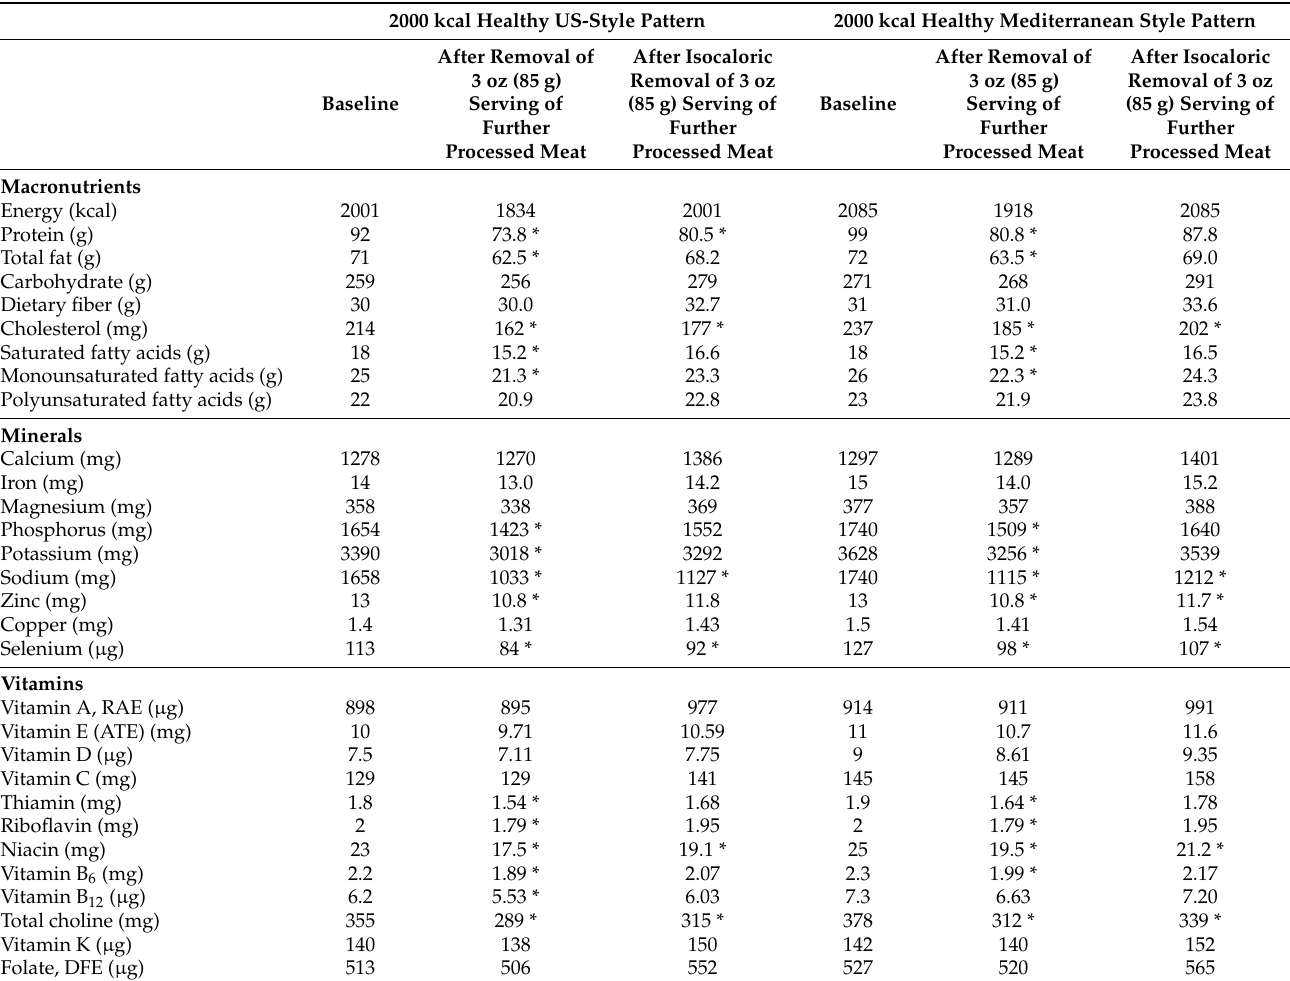
Table 6. Energy and nutrients in 2000 kcal Healthy Dietary Pattern before and after removal of a 3 oz (85 g) serving of further processed